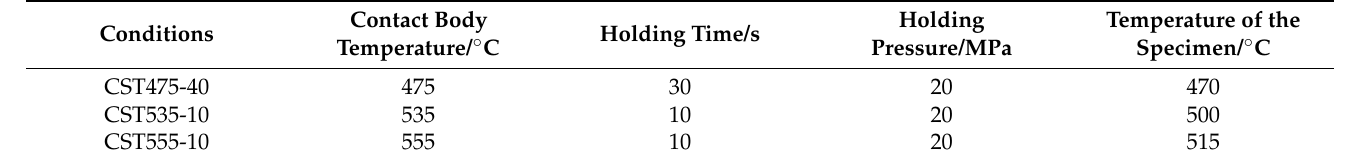
Table 2. Experimental parameters of contact solution treatment (CST).